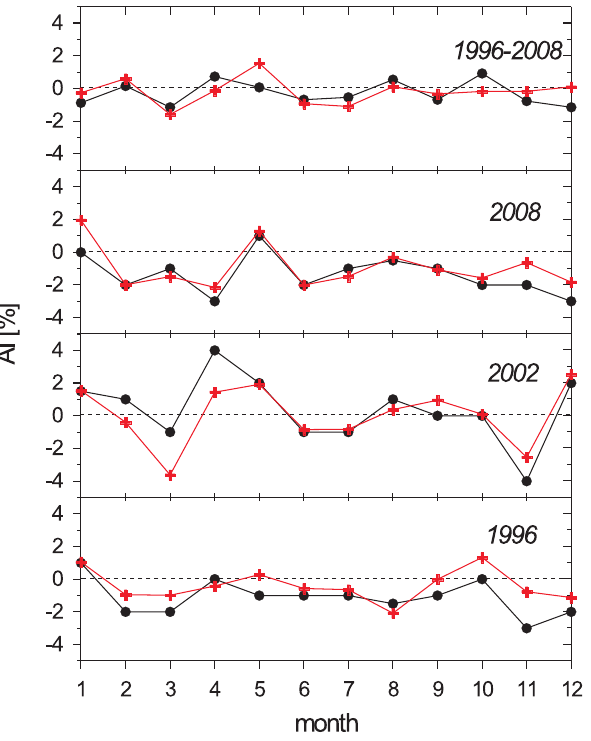
Fig. 8. Seasonal variations of mean AI values for different years (1996, 2002, and 2008) and for the full interval between 1996 and 2008 using monthly mean (red) or median values (black).